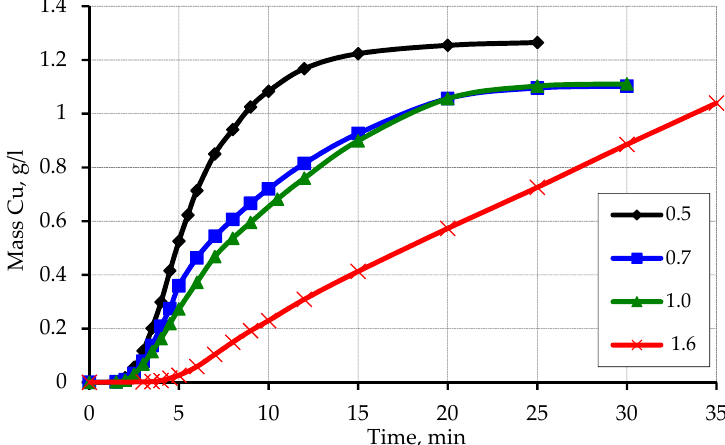
Figure 6. Kinetic curves of reduction of copper ions on the activated surface of polypropylene depending on the particle size. Concentration (mmol/L): CuSO4–48; EDTA-Na2–67; NaOH-250; formaldehyde–366.